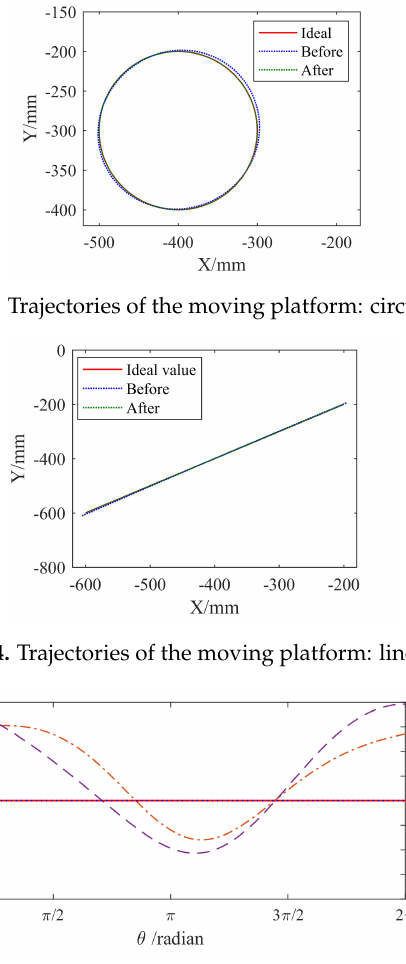
Figure 5. Trajectory errors relative to ideal situation: circular